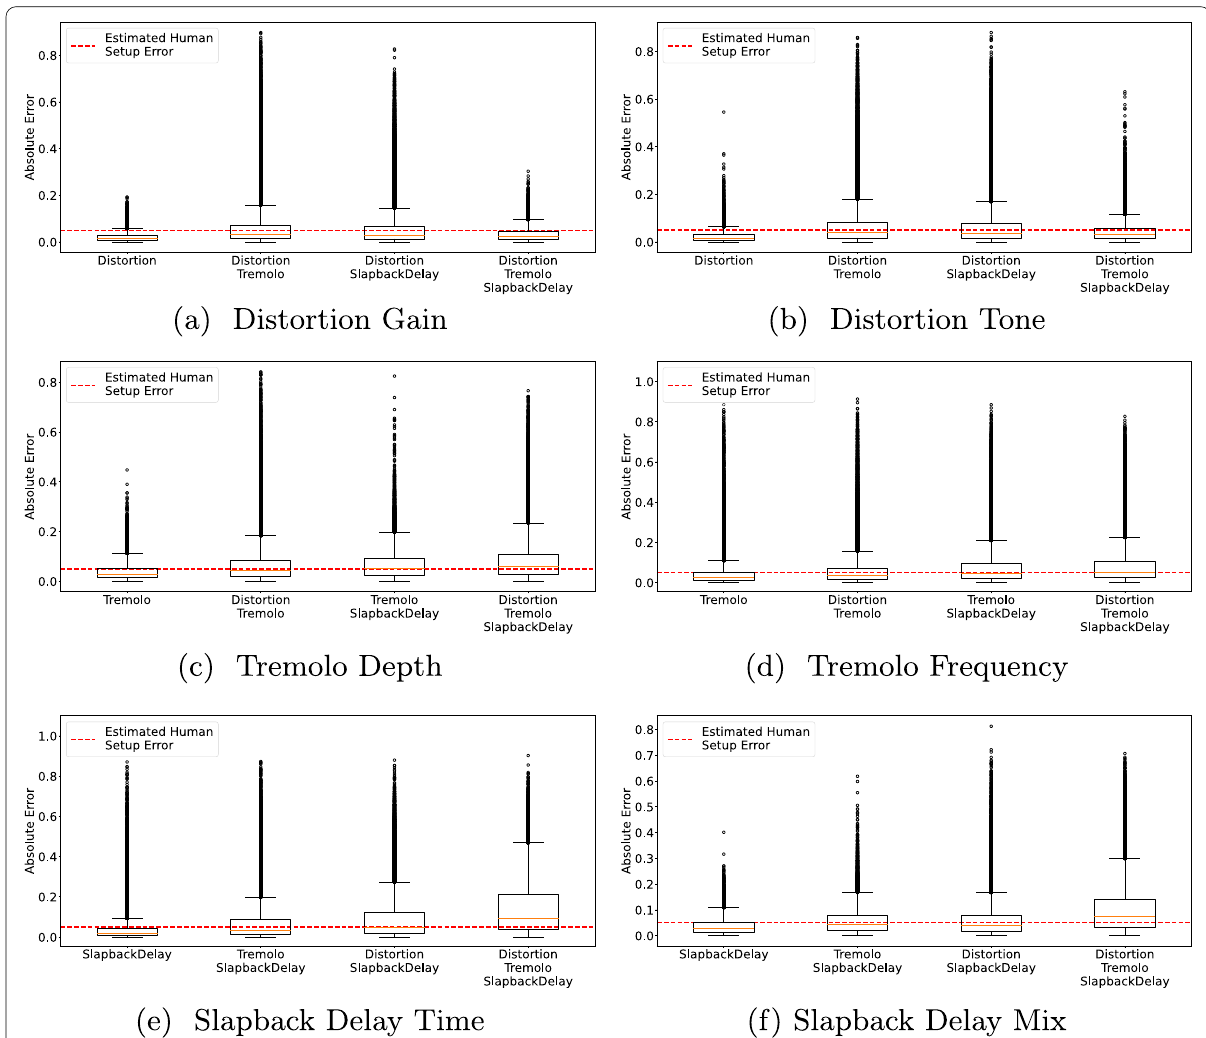
Fig. 9 Boxplots comparing the mean absolute error of the parameter extraction with respect to the effect combination. Depicted are the absolute parameter extraction errors for the a gain (distortion), b tone (distortion), c depth (tremolo), d frequency (tremolo), e time (slapback delay), and f mix (slapback delay) parameters. These results were achieved using the spectrogram as time-frequency